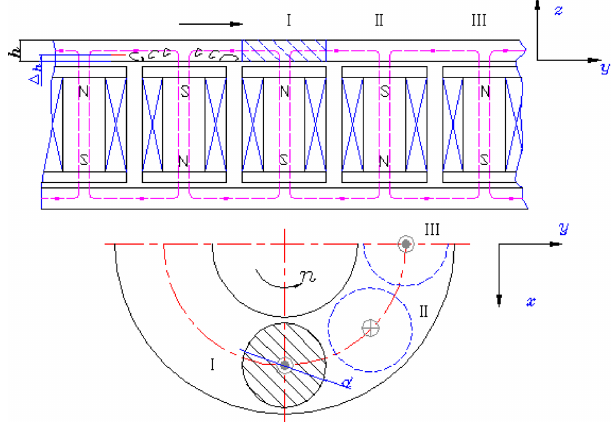
Figure 4. The action area of eddy